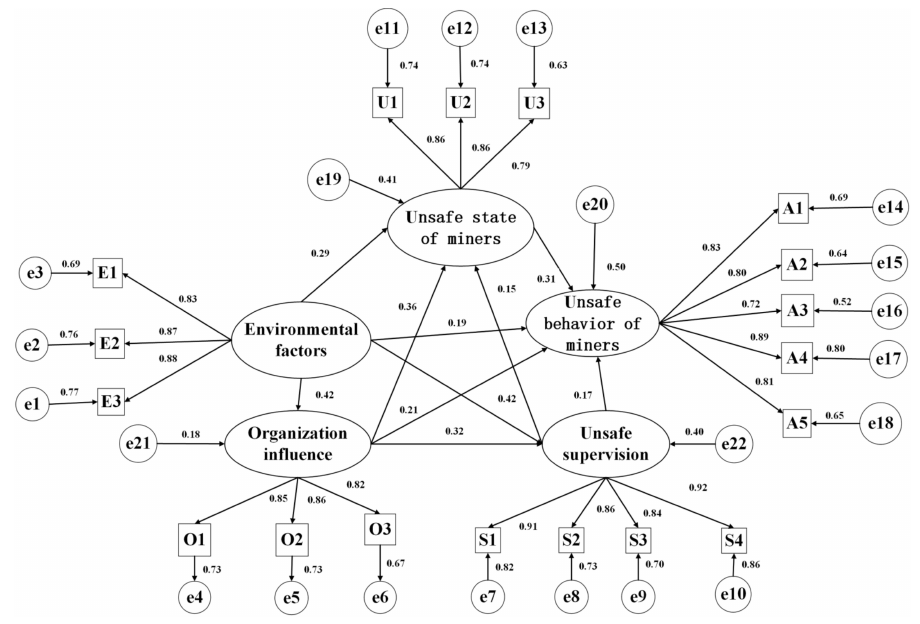
Figure 4. Standardized SEM of the formation mechanism of deep coal miners’ unsafe behavior.